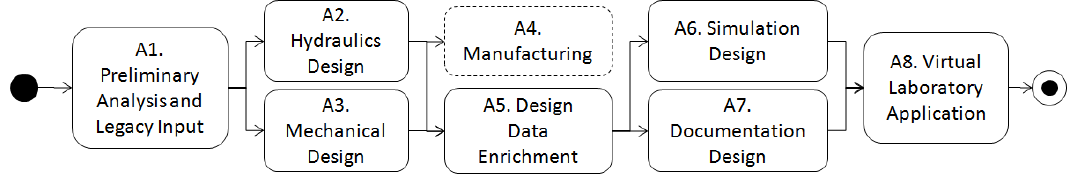
Figure 1. An intuitive example of a semantic design